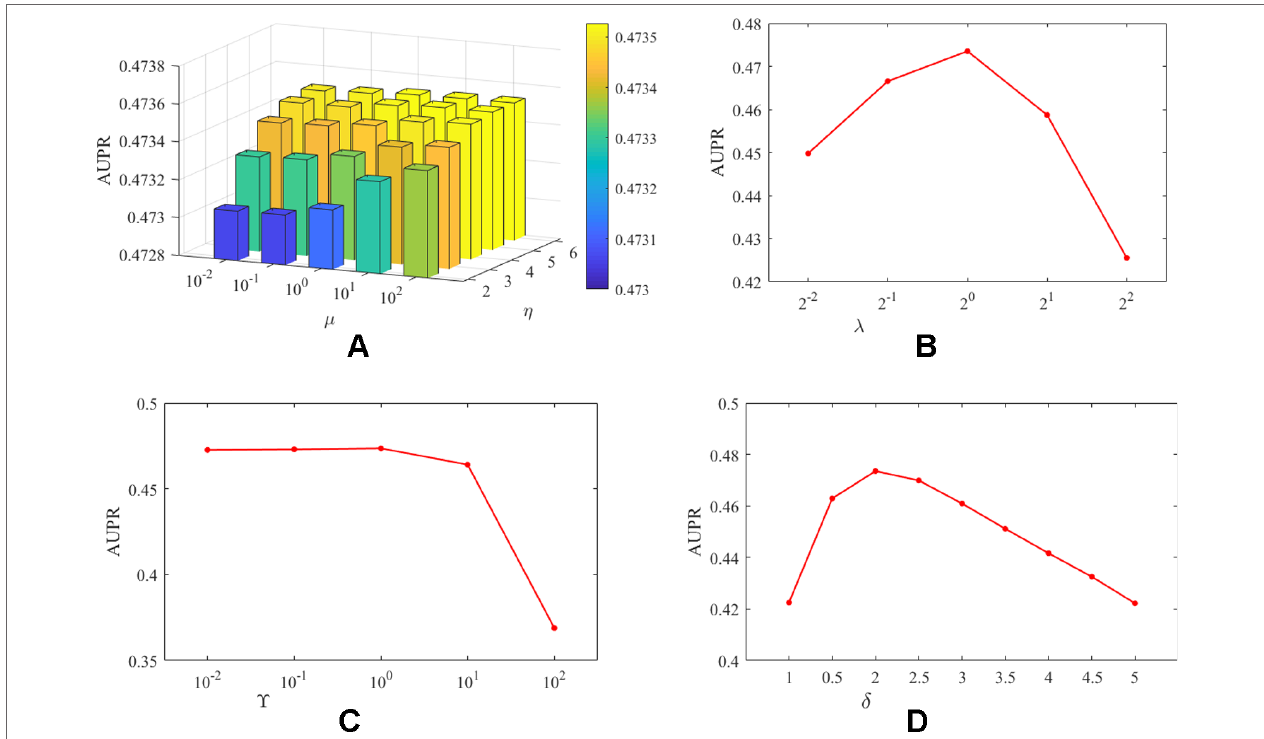
FIGURe 2 | The influence of parameters on the AUPR value of PMDKN. Among them, (A) represents the influence of the projection parameters µ and η on the AUPR value. (B) shows the effect of the neighborhood Laplacian regularization parameter λ. (C) shows the effect of the feature regularization parameter γ . (D) indicates the effect of observing the important level parameter